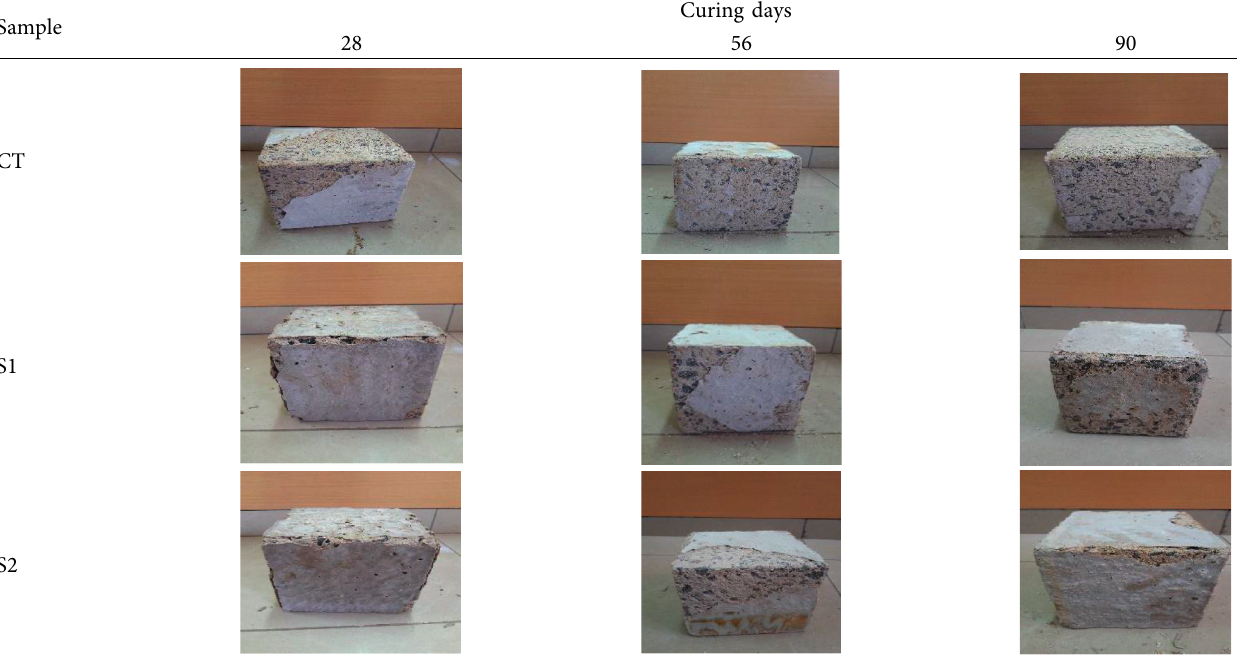
Table 6: Physical characteristics of concrete mixes after exposure to the sulphate solution: slight peeling of the surface is visible.